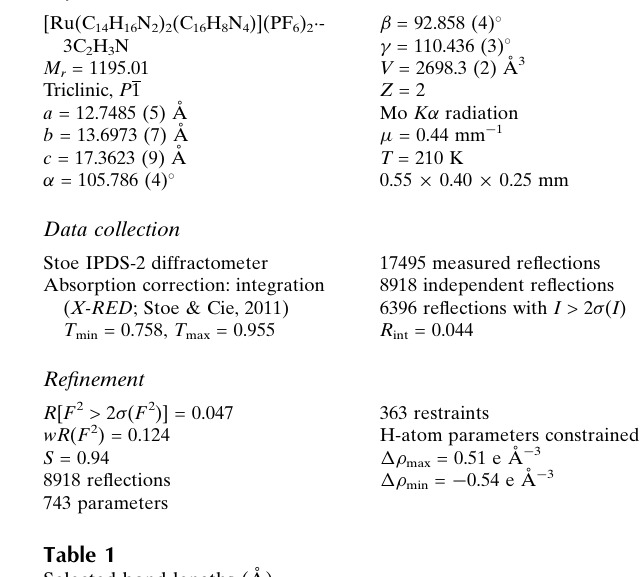
Selected bond lengths (A˚ ).